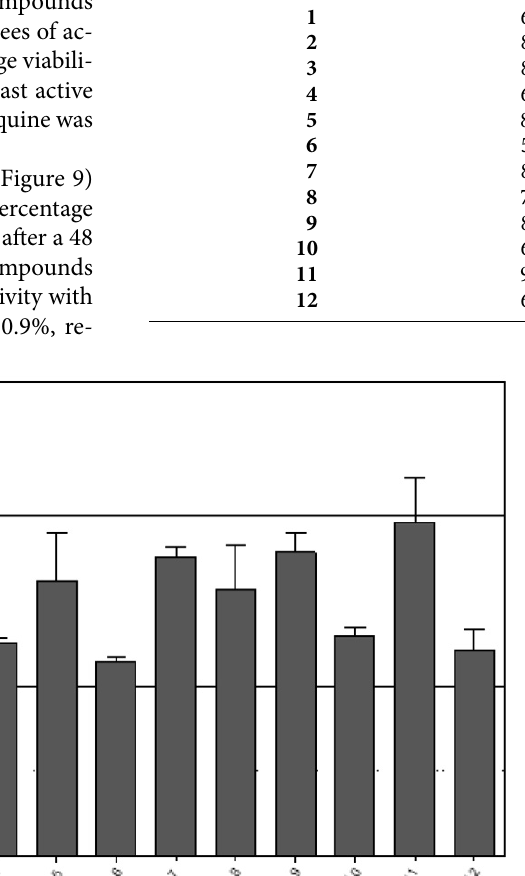
Table 6. Percentage parasite (Plasmodium falciparum strain 3D7) viability ± SD obtained for the compounds 1 – 12 . Compound Viability